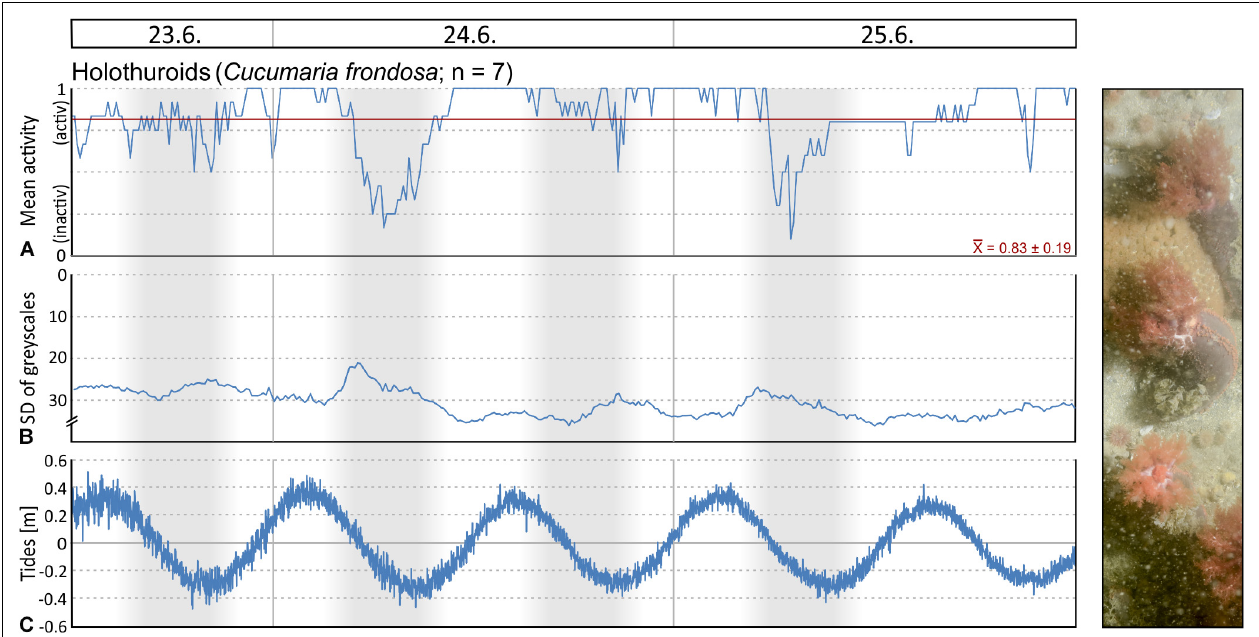
FIGURE 14 | (A) Mean filter-feeding activity and cumulative intermissions in activity per hour of holothuroids observed on images of the lander’s camera system during the 3 days of deployment at Bjørnøy-Banken. (B) Turbidity proxy (standard deviation of mean grey scales in each image). (C) Tidal curve; note the correlation to the feeding